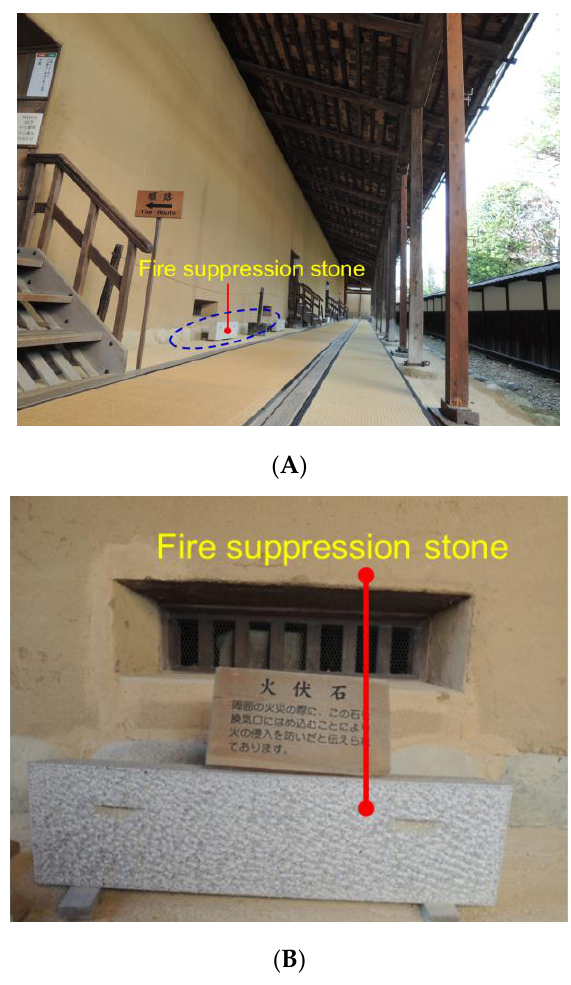
Figure 1. ( A ) Exterior of a Japanese barn during the Edo period (1603–1868). ( B ) A fire suppression stone used in Edo period barns.